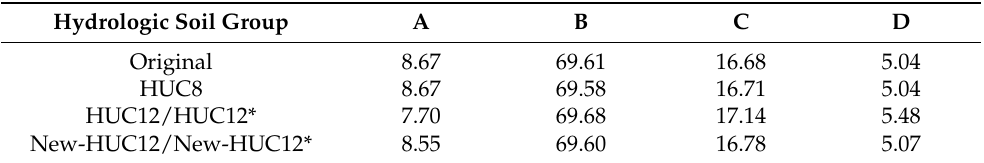
Table 4. Percentages of hydrologic soil groups (%) in different delineation scenarios. The original stands for the true soil distribution with 0% threshold. Hydrologic Soil